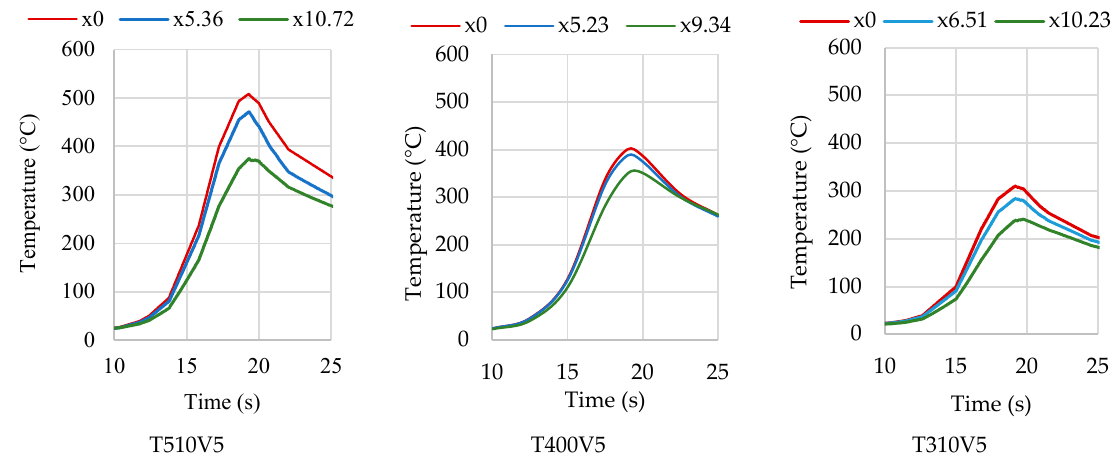
Figure 16. Thermal cycles recorded by thermocouples (v = 5 mm/s). The match between thermal cycles simulated with the FE model and those measured with thermocouples was achieved by varying the convective exchange coefficient in the region of the specimen in contact with the clamps. Figure 17 compares the temperature profiles estimated with the FE model (solid line) with the peak temperatures measured by thermocouples (circles marker) in physical simulation tests of thermal cycles relating to the treatment speed of 5 mm/s and at peak temperatures at midpoints of about 500 °C, 400 °C and 300 °C. The high fit between the experimental and numerical results in the points where the thermocouples were welded was recorded for all physical simulation tests that were carried out.